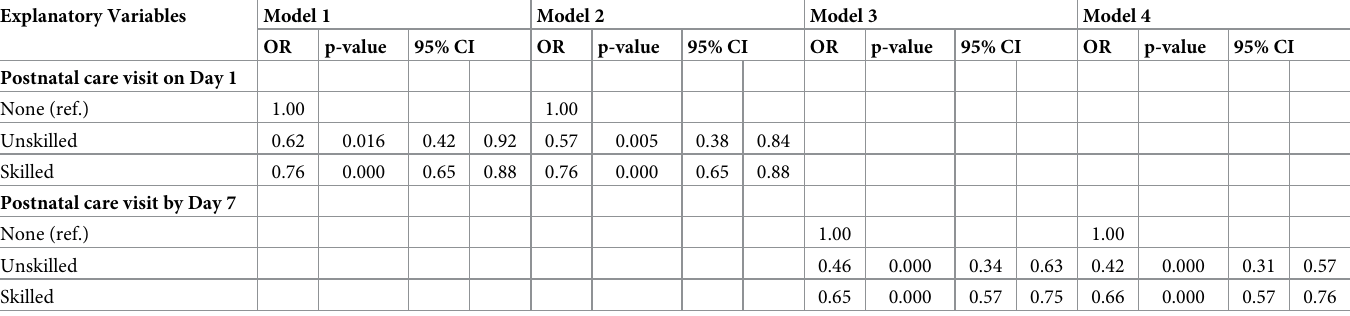
Table 4. Parameter estimates (Odds Ratio) for binary weighted logistic regression models of neonate deaths between Days 2 and 28 by PNC type and other selected background variables, India